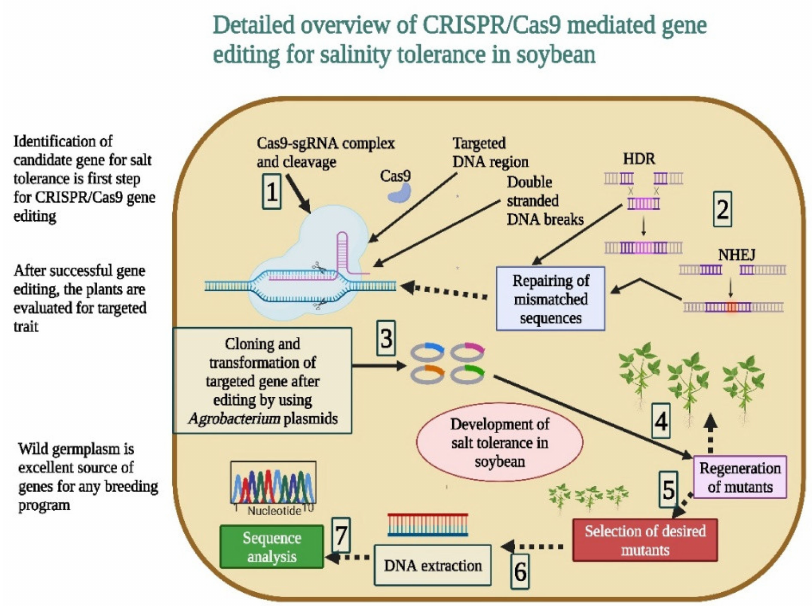
Figure 3. CRISPR/Cas9-mediated gene editing plays a key role in the development of salt-tolerant soybean genotypes. It develops the transgene-free cultivars to ensure biosafety regulations. The editing of genes for salt tolerance makes this tool highly efficient with less errors. This Figure is created with